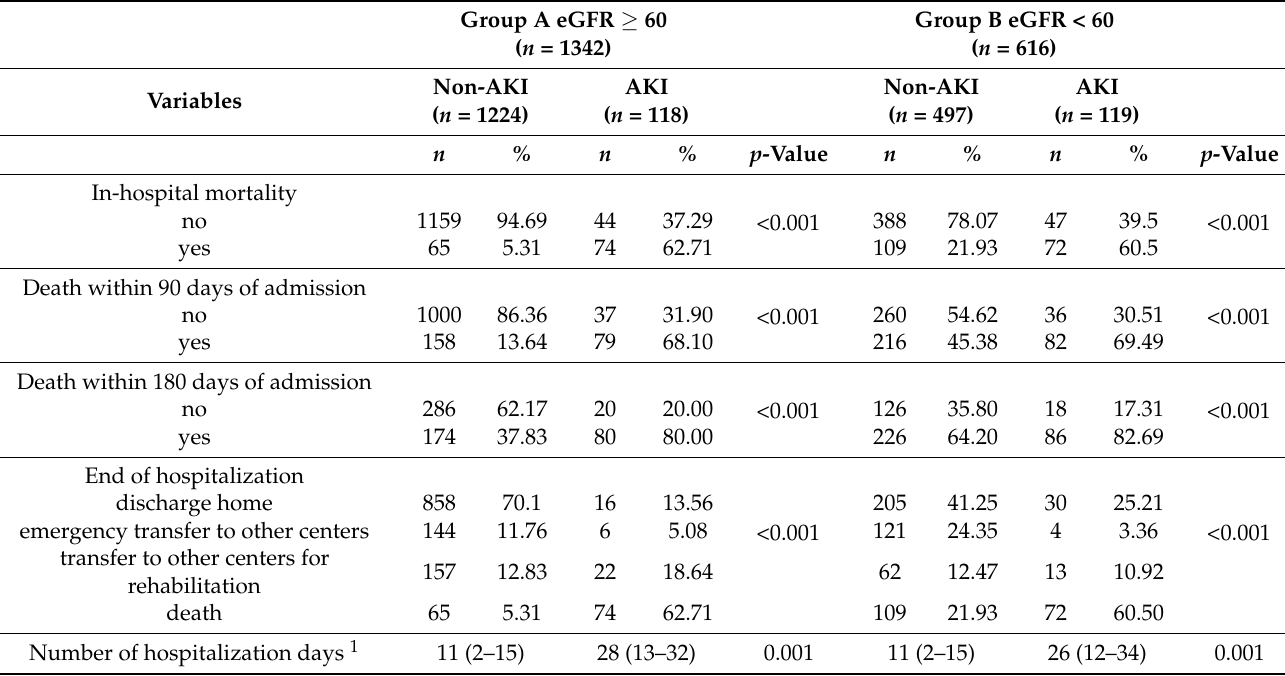
Table 11. Comparison of outcomes between groups of COVID-19 patients divided according to eGFR level and appearance of AKI.